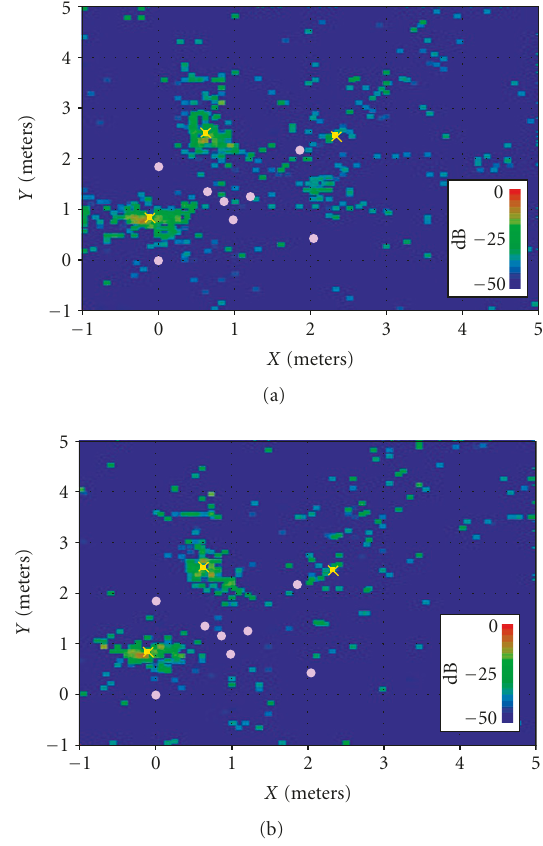
Figure 8: Energy localization map for a 28s.-long audio sequence featuring 3 speakers inside a room (indicated by the three yellow crosses). Light-purple dots show the location of the 8 microphones. The top map is computed using AMDF-based TDOA estimation while the bottom map is computed using GCC-PHAT. Both maps were computed using 8 subbands and corresponding energy is inte- grated over the entire duration of the